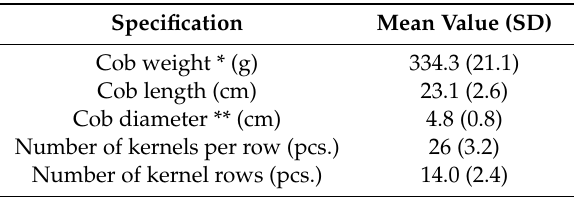
Table 1. The characteristics of the tested